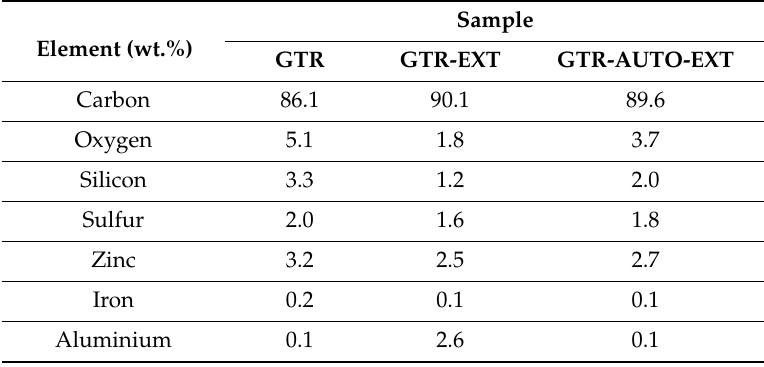
Table 6. Elemental composition of GTR and reclaimed GTR determined by energy-dispersive X-ray spectroscopy.